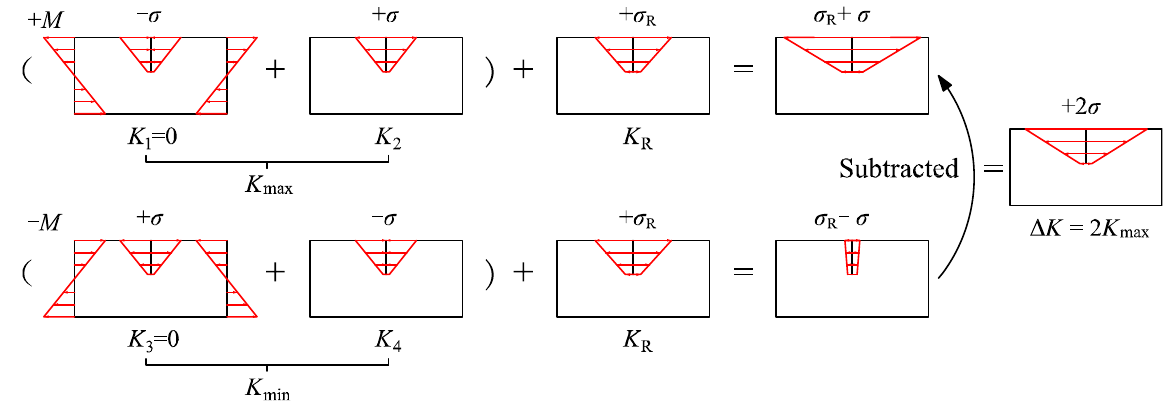
Figure 18. Calculating K Δ in tensile residual stress fields by superposition. Seventh order polynomials were used to fit the crack propagation data ( N , a ) their derivatives were calculated to obtain the crack propagation rates d a /d N . Figure 19 shows the relationship between d a /d N and K Δ . As the d a /d N corresponding to the first and last dark bands of beach marks only considered one-sided data, they were not included in this figure.